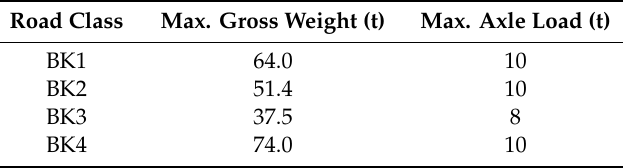
Table 1. Definition of road classes in the Swedish public road network